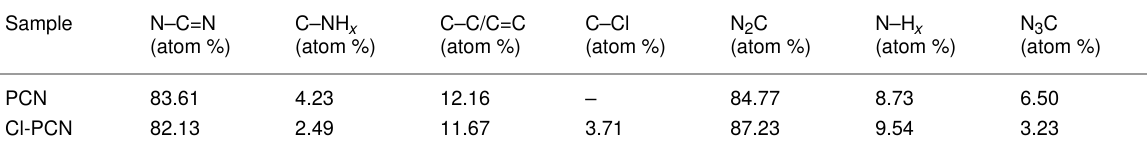
Table 2: Chemical composition of PCN and Cl-PCN calculated from the peak-fitting procedure applied to the N 1s and C 1s spectra of the samples.